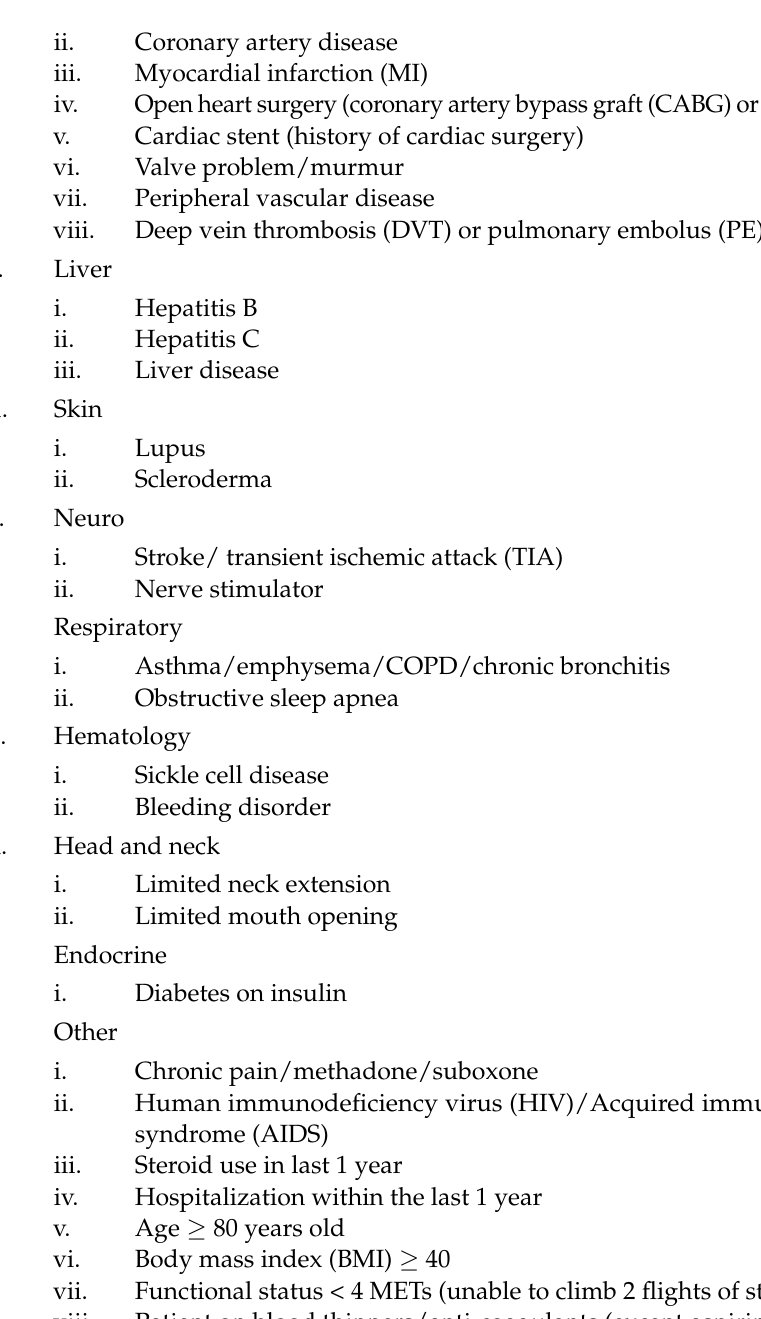
Patient on blood thinners/anti-coagulants (except aspirin) Note: For surgeries scheduled within 5 days of their surgery date, an NP review will become a PAT